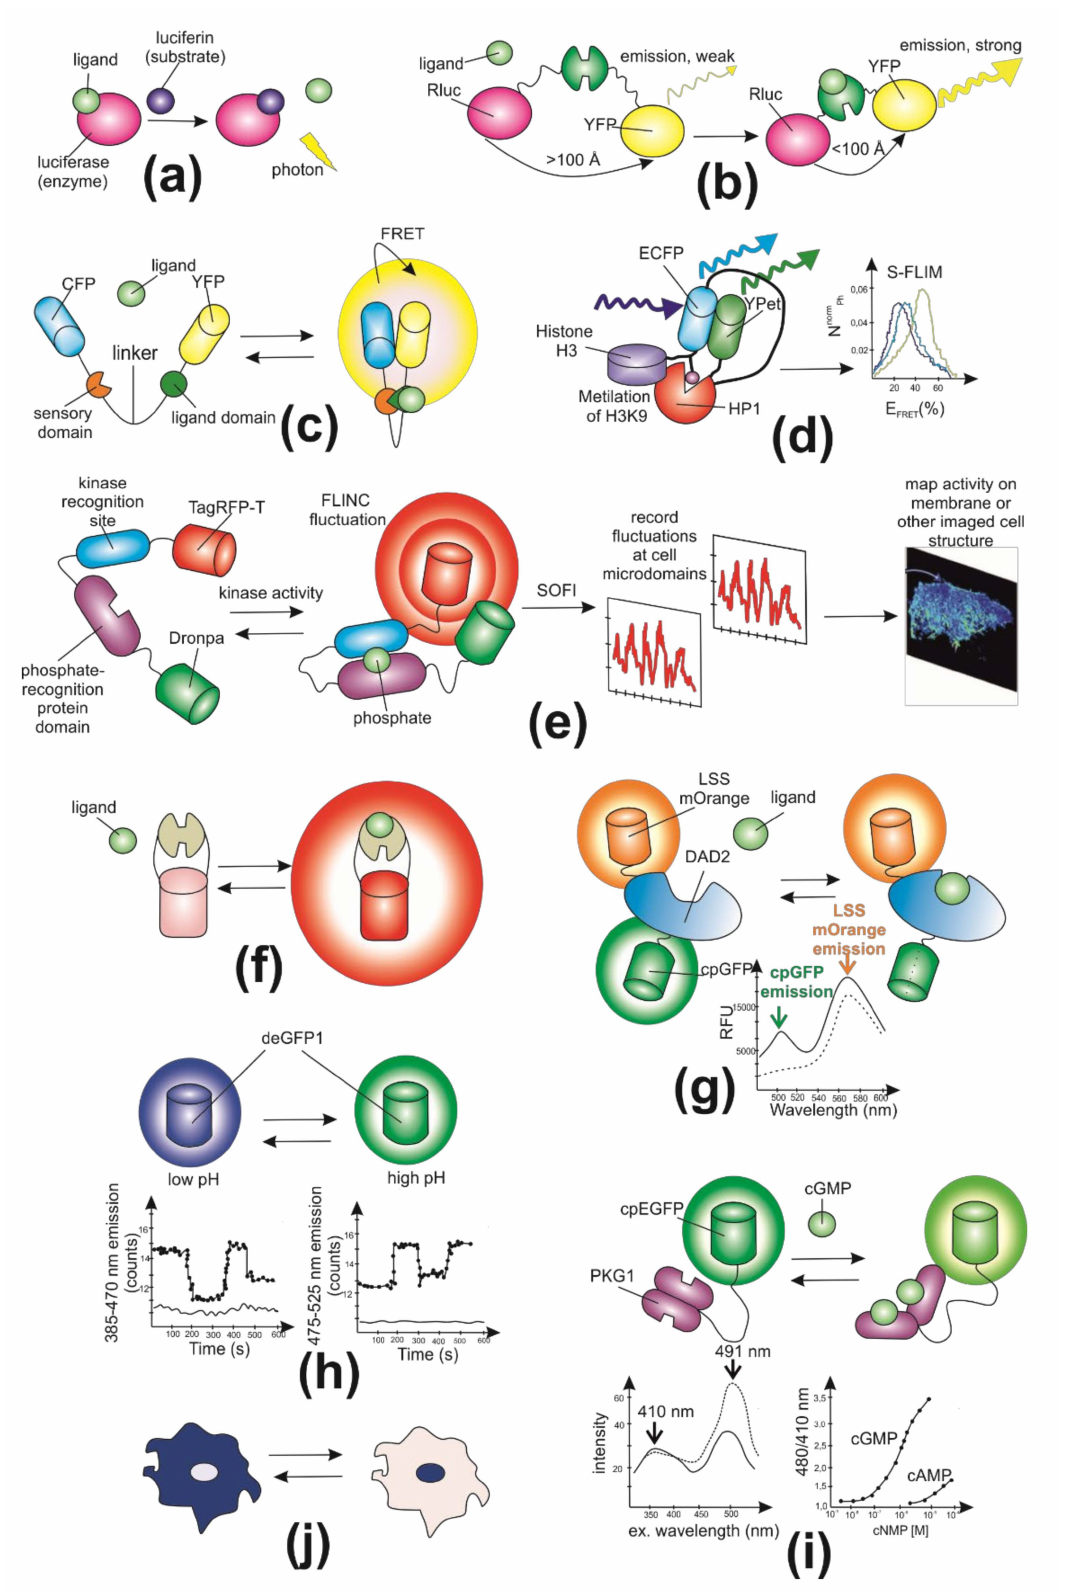
Figure 2. General types of biosensors grouped with principles of their readout mechanisms. ( a ) Schematic representation of bioluminescence intensity-based biosensor; ( b ) schematic representation of BRET biosensor; Rluc— Renilla luciferase,